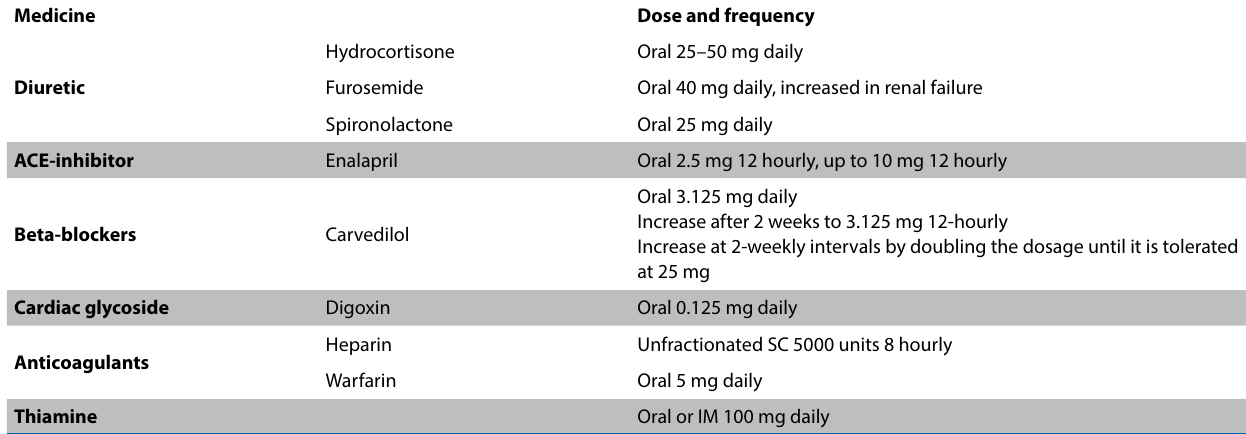
Table lll: Pharmacological management of congestive cardiac failure according to the South African Standard Treatment Guidelines and Essential Medicine List, 2012 17 Medicine